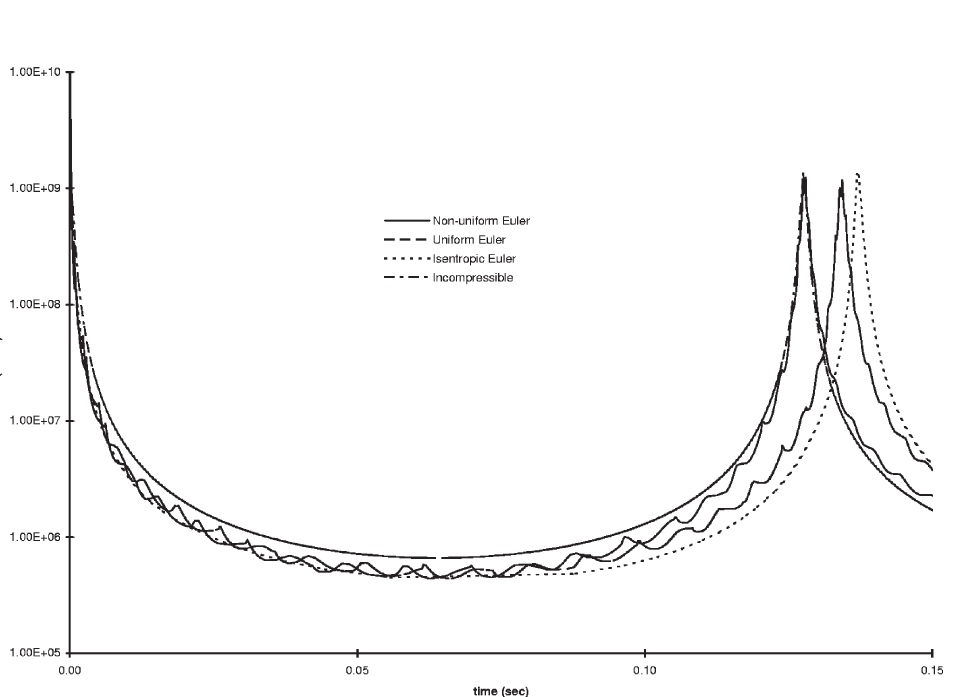
Fig. 8. Comparison of interface bubble